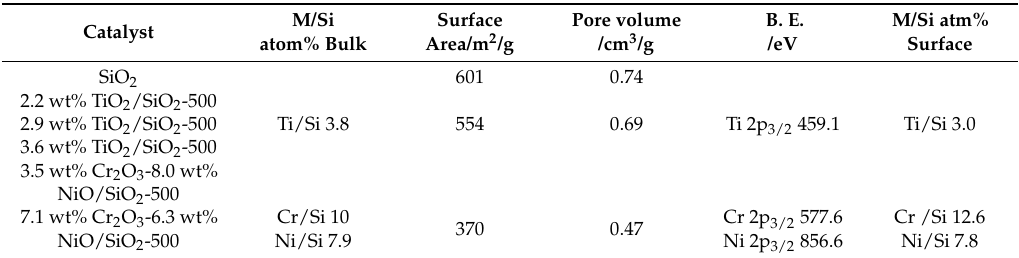
Table 1. Typical physicochemical properties of TiO 2 /SiO 2 , Cr 2 O 3 -NiO/SiO 2 , and TiO 2 -Cr 2 O 3 /SiO 2 catalysts with different composition.